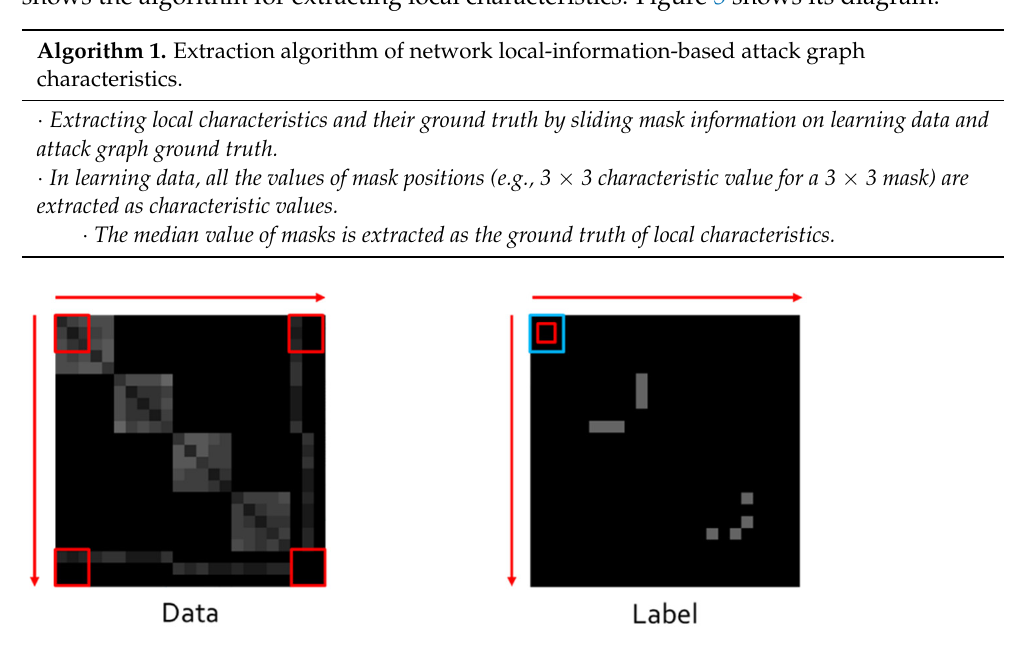
Figure 5. Local characteristics extraction method.